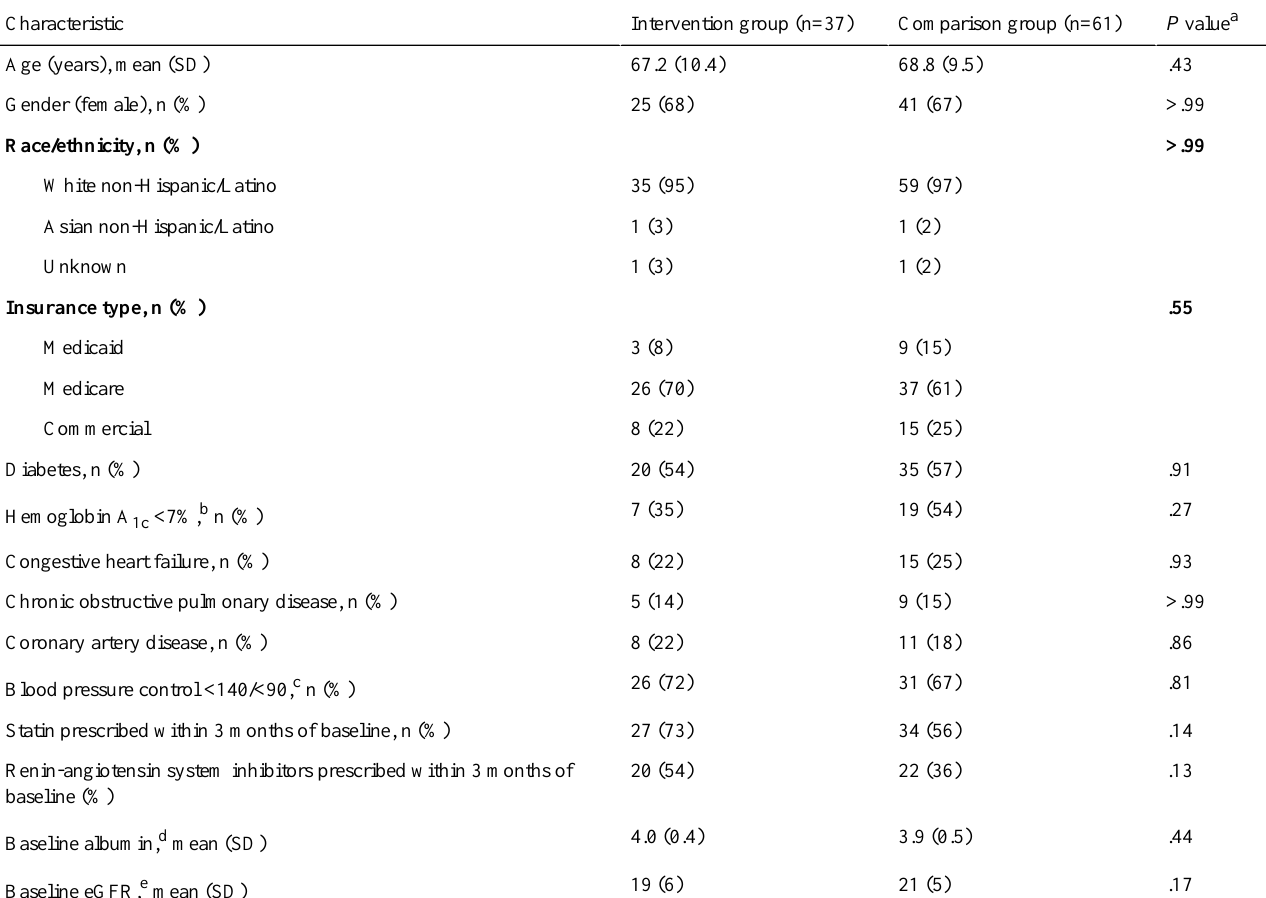
Table 1. Baseline characteristics of participants.